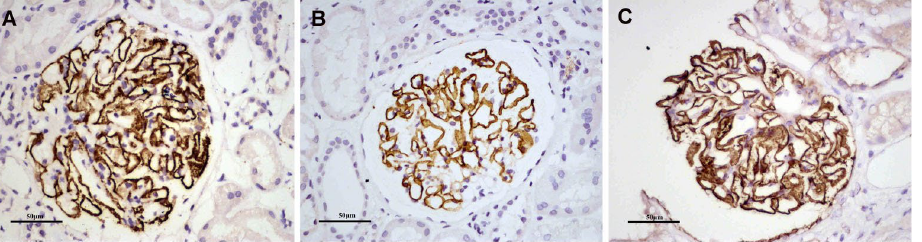
Figure 5. Positive staining for glomerular PLA2R ( A ), NELL-1 ( B ) and THSD7A ( C ) by immunohistochemistry, respectively. (Original magnification ×400).